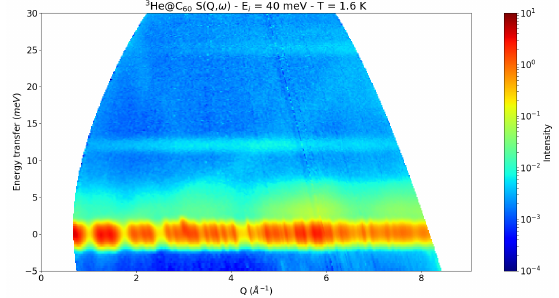
Figure 5. 3 He trapped inside C 60 at T = 1 . 6 K showing quantum transitions at energies of 11 and 24